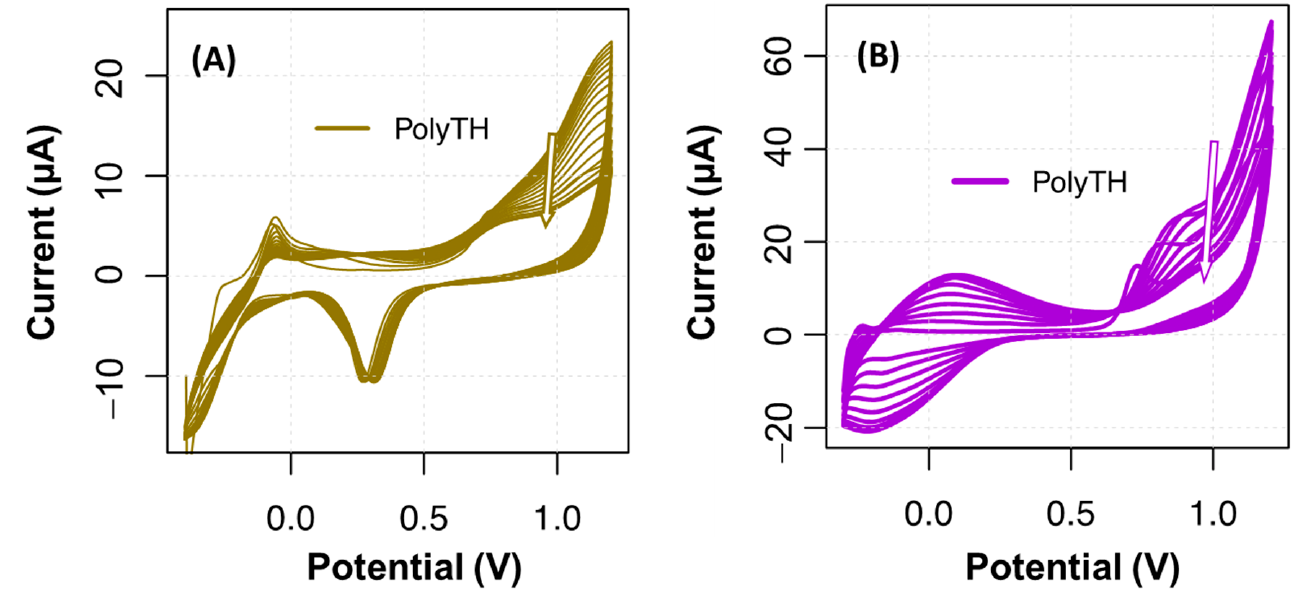
Figure 2. Consecutive voltammograms of a TH solution of 1.0 × 10 − 3 M prepared in phosphate buffer, between − 0.4 and 1.2 V, at a scan rate of 0.050 V/s for 15 cycles: ( A ) PolyTH, onto gold surface ( B ) and carbon surface.